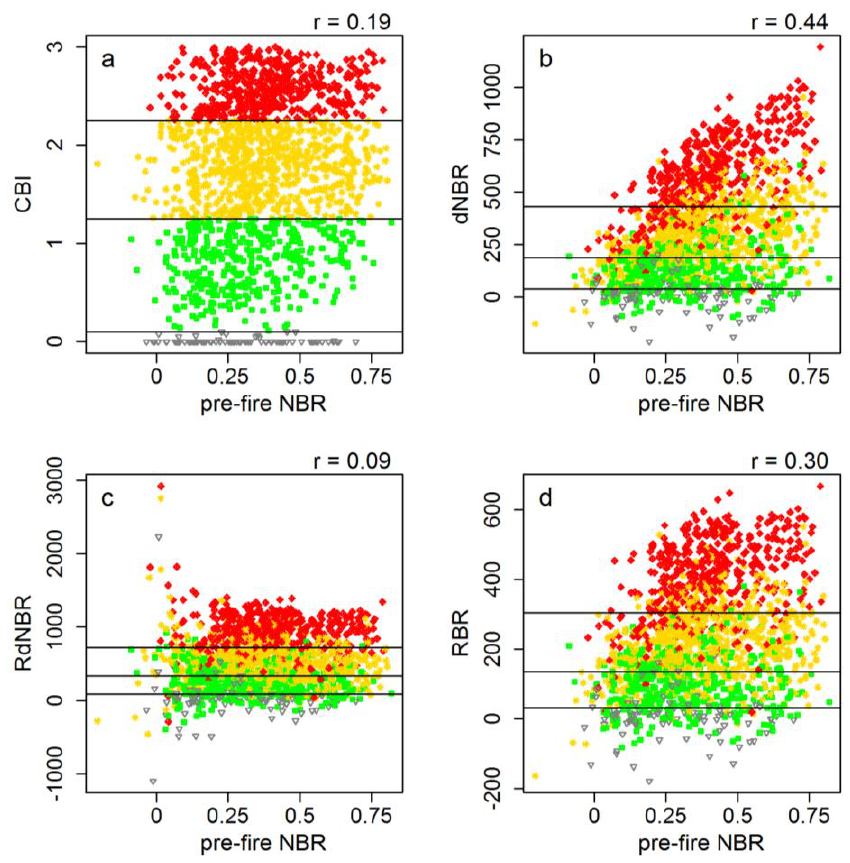
Figure 3. Correlations between pre-fire NBR (x-axis) and CBI ( a ), dNBR ( b ), RdNBR ( c ), and RBR ( d ), using all 1,681 plots. Pearson’s correlation is shown in the upper right of each pane. Plots are colored and symbolized by their field-measured CBI severity class: unchanged (gray inverted triangles), low (green boxes), moderate (yellow asterisks), and high (red diamonds). Horizontal lines are the burn severity class thresholds for each metric (calculated with all plots for dNBR, RdNBR, and